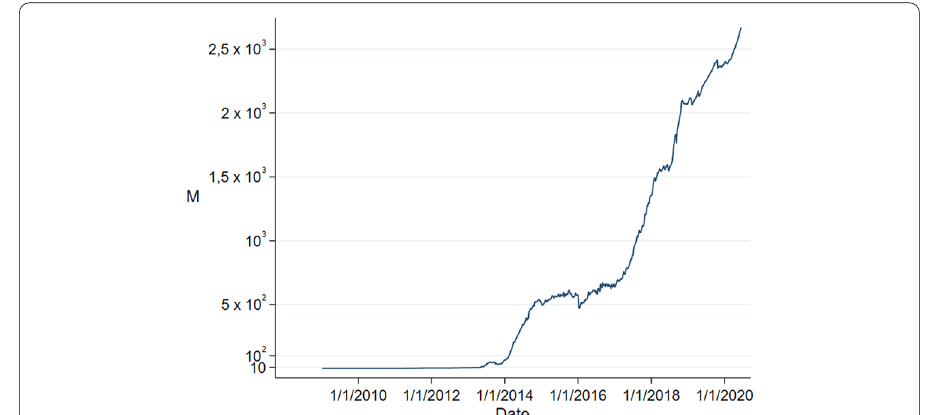
Fig. 1 Illustration of the number of Cryptocurrencies by date. Source : Own estimations